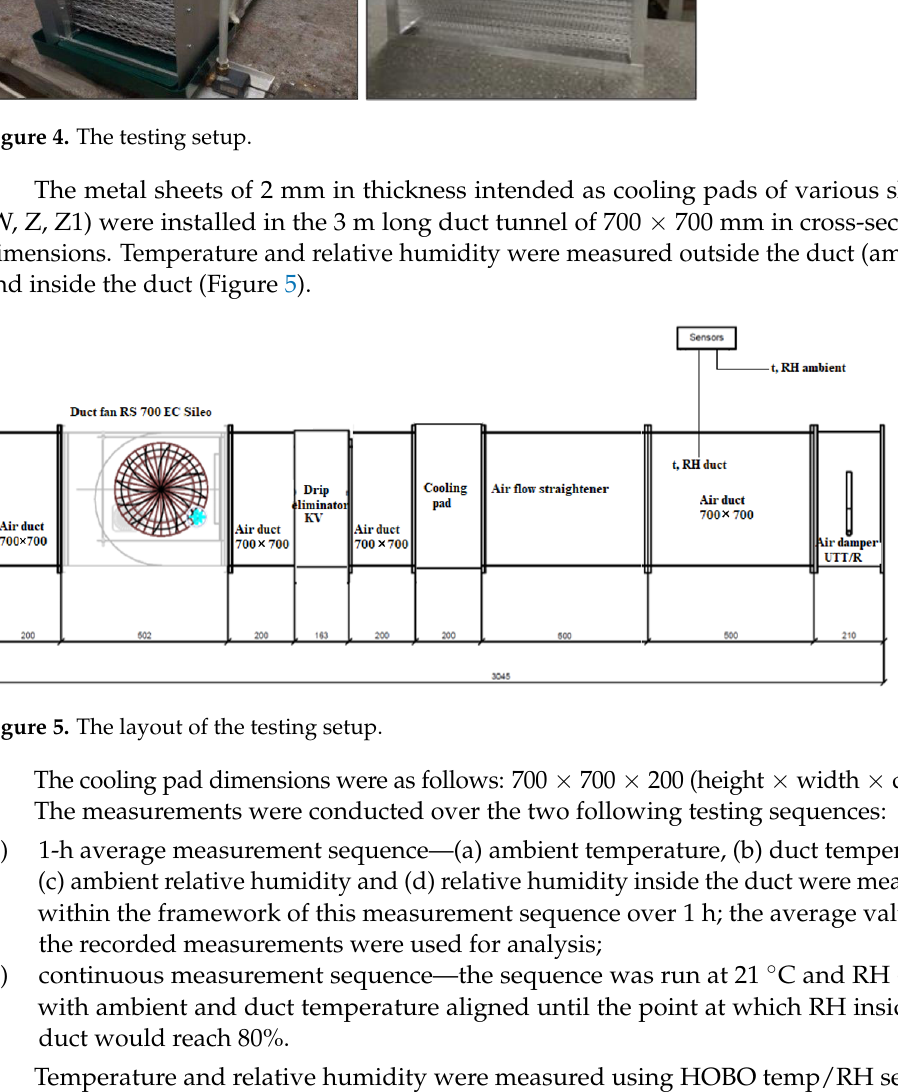
Table 1. Technical specifications of HOBO temp/RH sensors employed in.